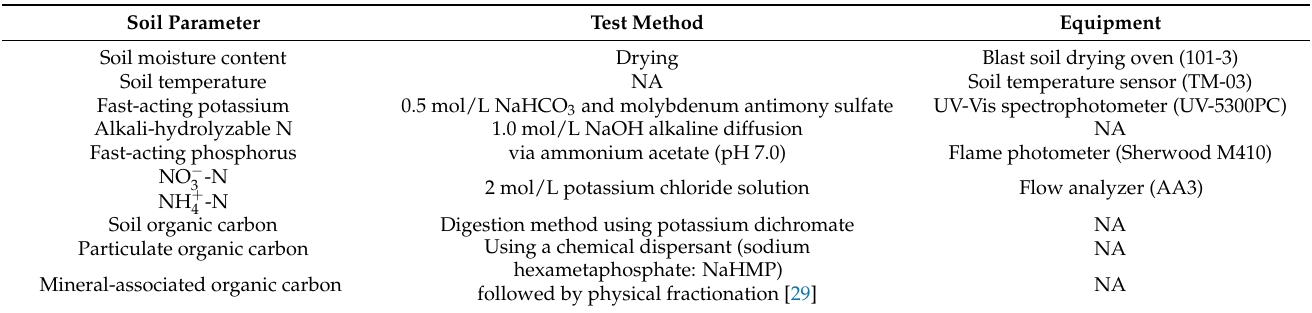
Table 2. Methods and equipment for the determination of soil physicochemical